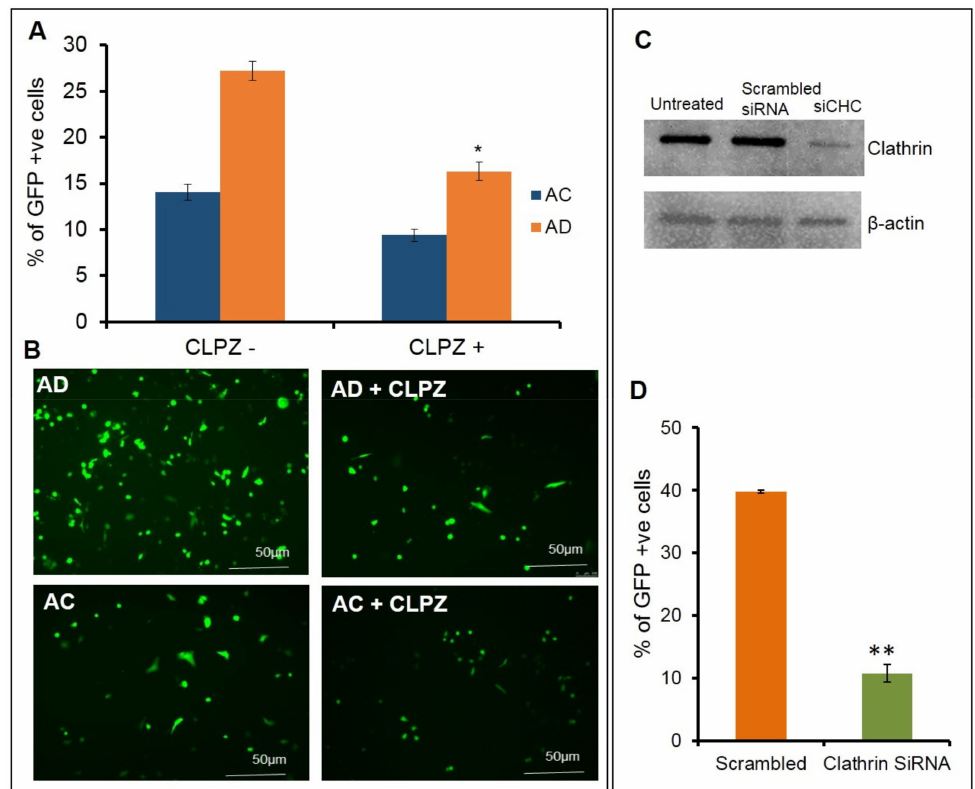
Figure 3. Effect of clathrin inhibitors/blockers on transfection activity. Transfection activity in chlorpromazine (CLPZ) pretreated SK-Hep1 cells ( A , B ). % of GFP-positive cells assessed by Flow cytometric analysis ( A ). Representative fluorescence micrographic images of cells transfected using AD ( B upper panel) and AC ( B lower panel). Clathrin knockdown efficiency demonstrated with Western blot ( C ). Transfection activity (GFP expression) after knockdown of clathrinid in SK-Hep1 cells assessed by Flow cytometric analysis ( D ). * p < 0.05; ** p <